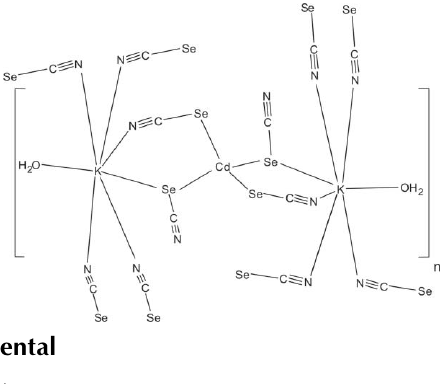
Experimental Crystal data